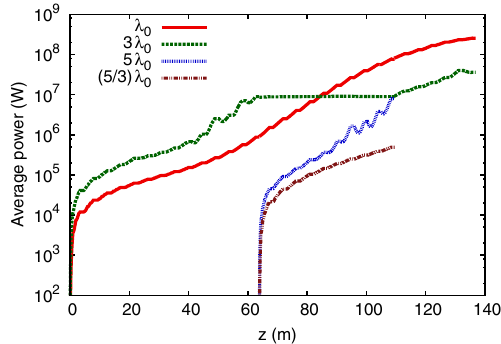
FIG. 7. Average power produced at various wavelengths as a function of distance for the three-stage example.